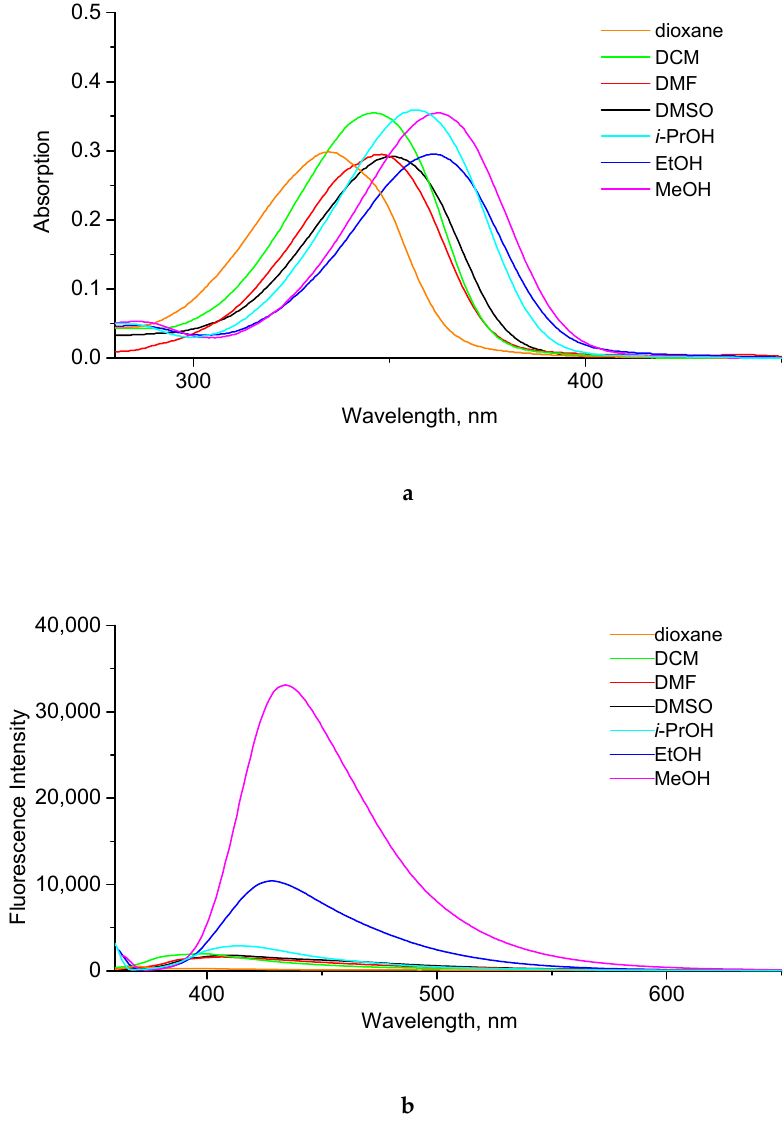
Figure 2. Absorption ( a ) and emission ( b ) spectra of compound 4a in various solvents (C = 1.0 × 10 − 5 M). Table 3. Absorption and fluorescence spectral data of compound 4a in various solvents (C = 1.0 × 10 − 5 M).